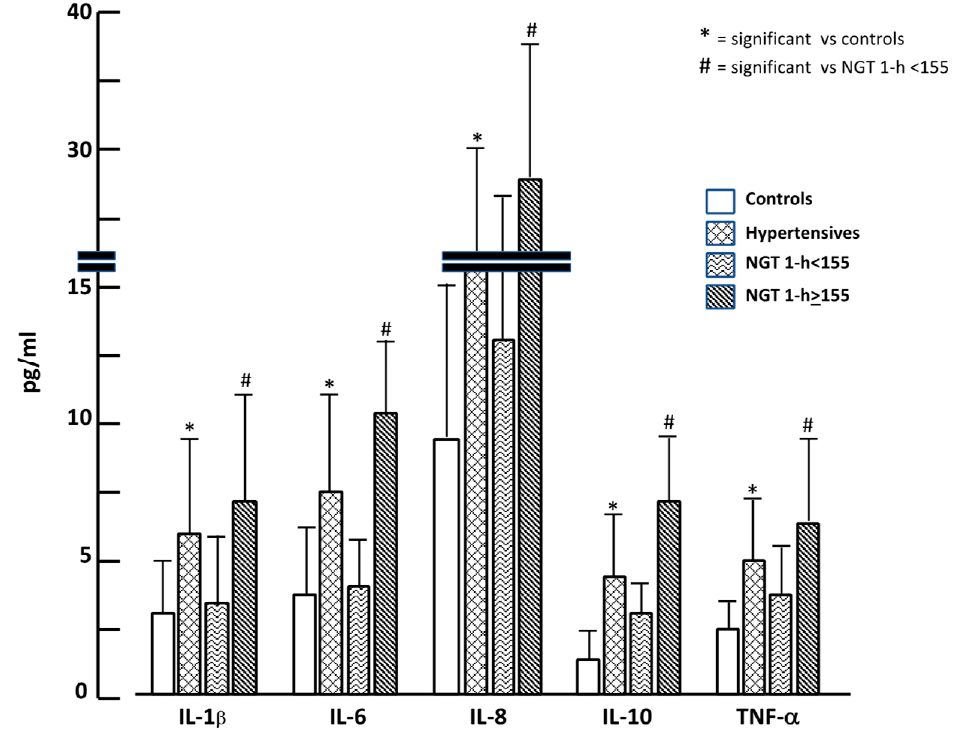
Figure 2. Inflammatory cytokine values in the four study groups.